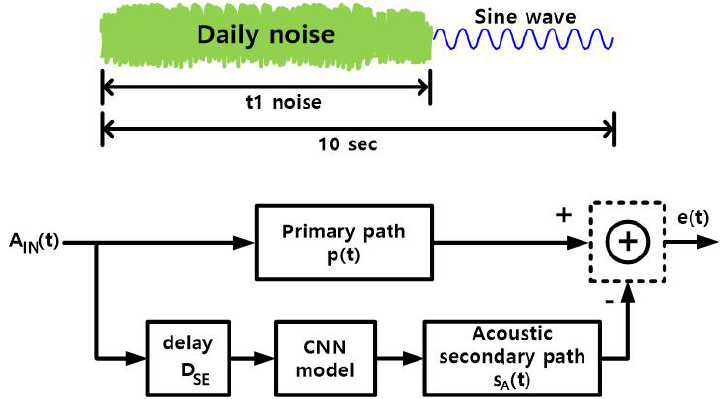
Figure 9. Training scheme of the proposed CNN